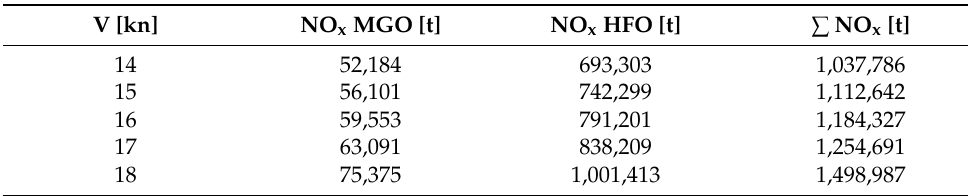
Table 9. Estimated amount of NO x emissions in container shipping under Tier III conditions (i.e., with SCR used) for 2021.